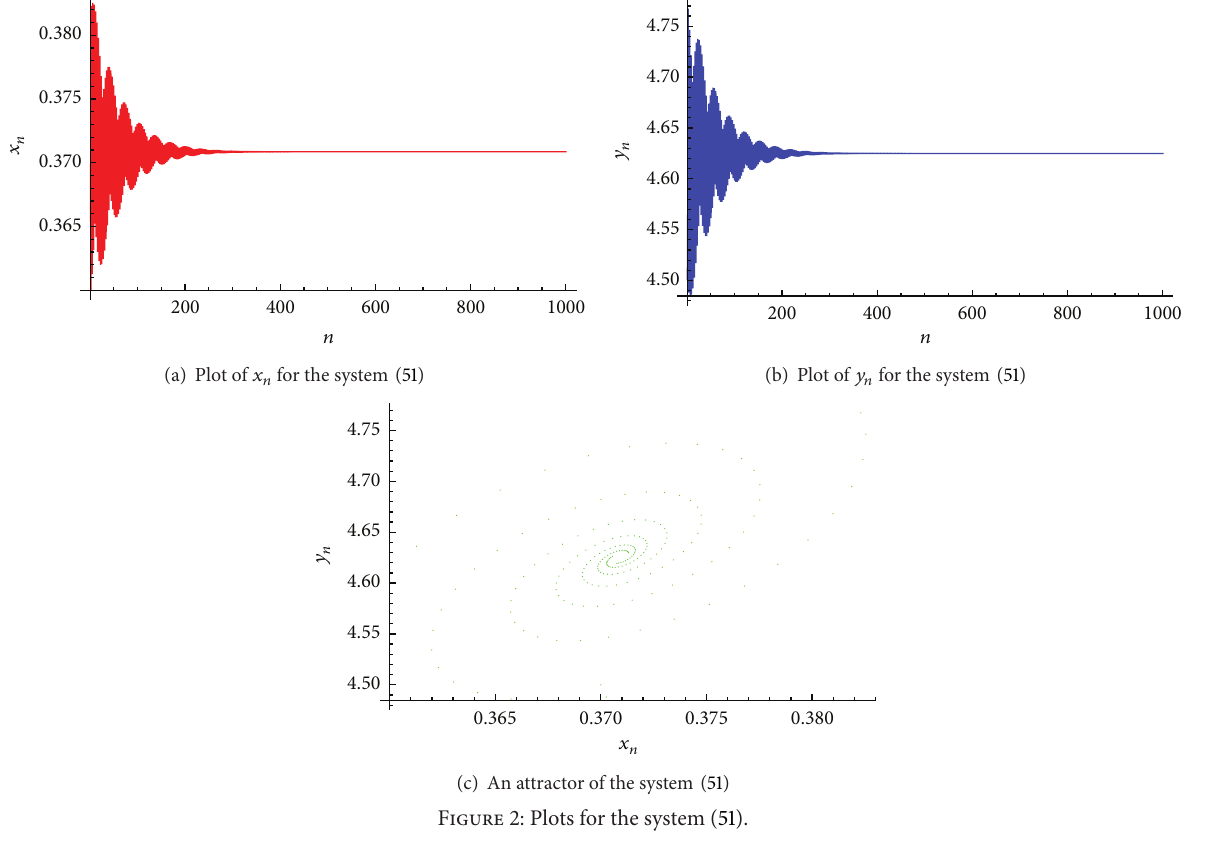
Figure 2: Plots for the system